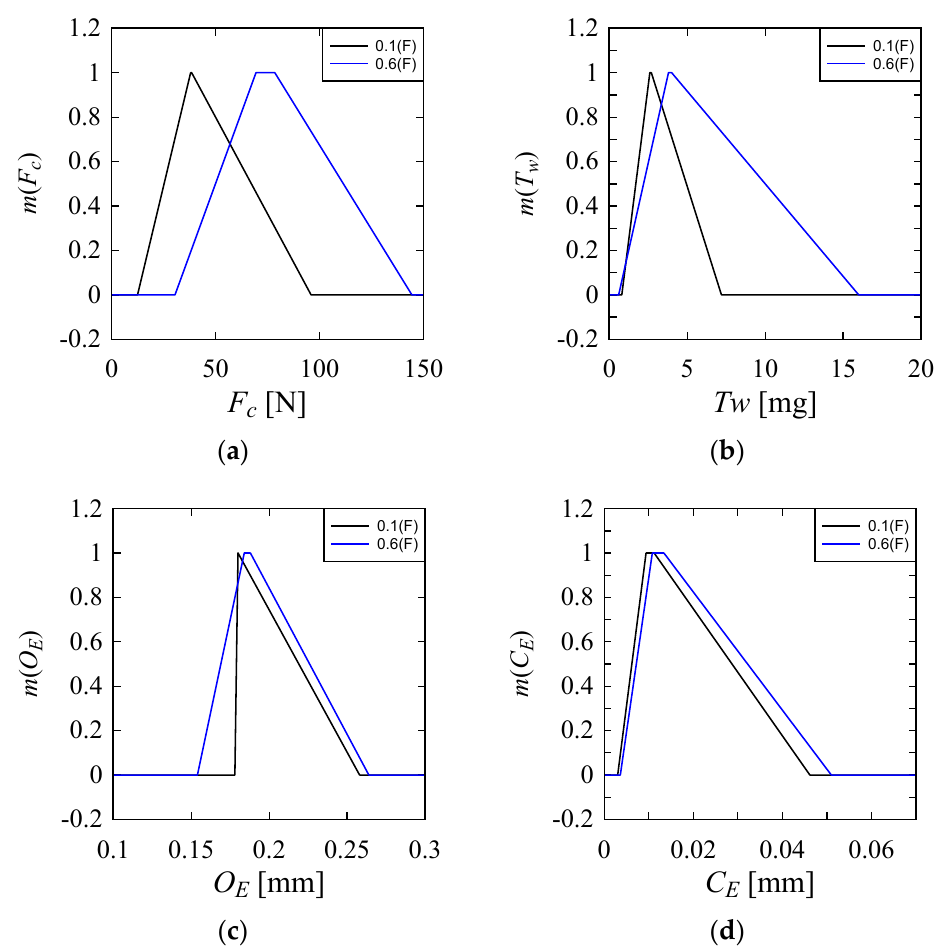
Figure 6. Effect of feed on the performance parameters ( a ) On Cutting Force ( F C ); ( b ) On Tool Wear ( T W ); ( c ) On Over Cut Error ( O E ); ( d ) On Cylindricity Error ( C E ).